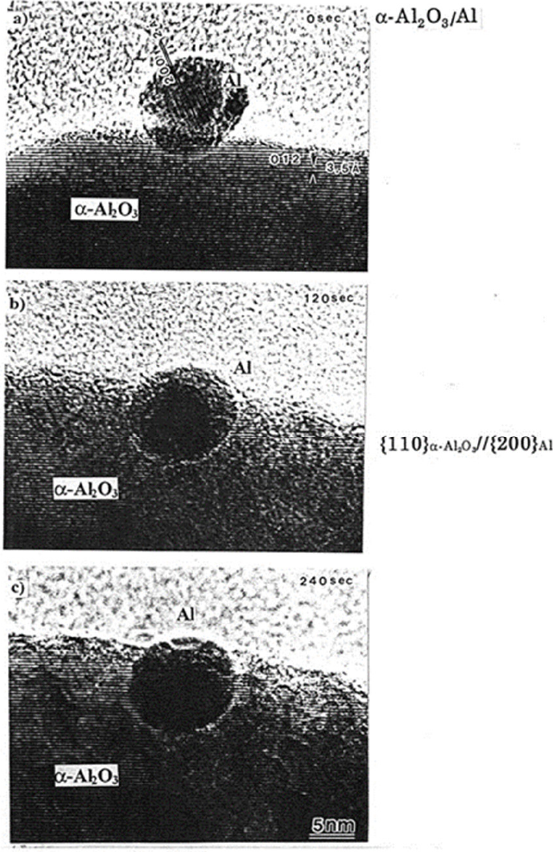
Figure 9. Al nanoparticle migrated and embedded into the α -Al 2 O 3 matrix by electron irradiation of the order of 10 20 e/cm 2 s for ( a ) 0 s ( b ) 120 s and ( c ) 240 s. The α -Al 2 O 3 /Al interface structure exhibits a {11–20} α -Al 2 O 3 //{200}Al epitaxial relationship even after electron irradiation for 240 s [9].